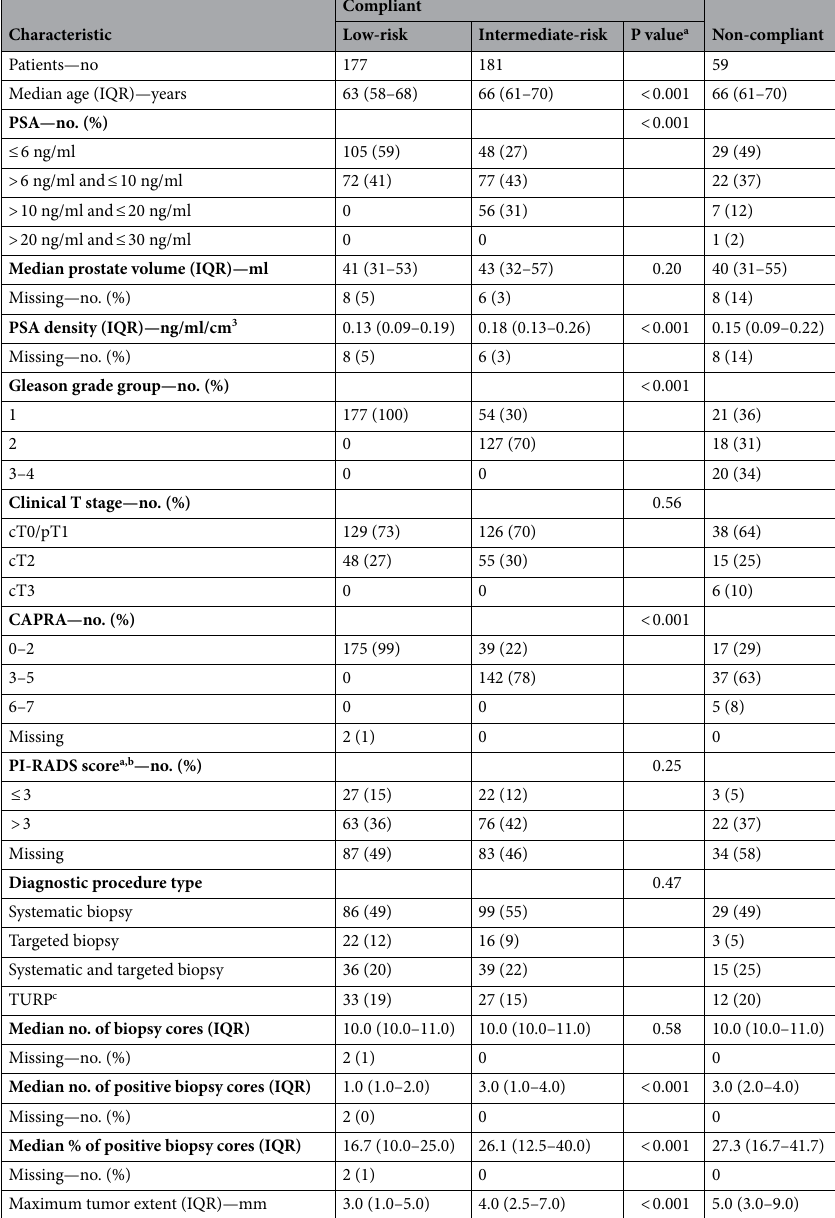
Table 2. Baseline clinicopathologic characteristics of 417 patients undergoing active surveillance Vestfold Hospital Trust stratified at stratified by compliance with active surveillance protocol and risk group. CAPRA cancer of the prostate risk assessment, IQR interquartile range, PI-RADS prostate imaging–reporting and data system, PSA prostate-specific antigen, TURP transurethral resection of the prostate. a Fisher’s exact (categorical variables) or Mann–Whitney’s U (continuous variables) test were used to evaluate associations between baseline characteristic and risk group for the compliant patients. b Based on multiparametric magnetic resonance imaging scan performed before diagnostic biopsy. c The tumor percentage was < 5% in 47 (65%) patients and ≥ 5% in 25 (35%) patients diagnosed with TURP. Note: Percentages may not sum to 100 due to